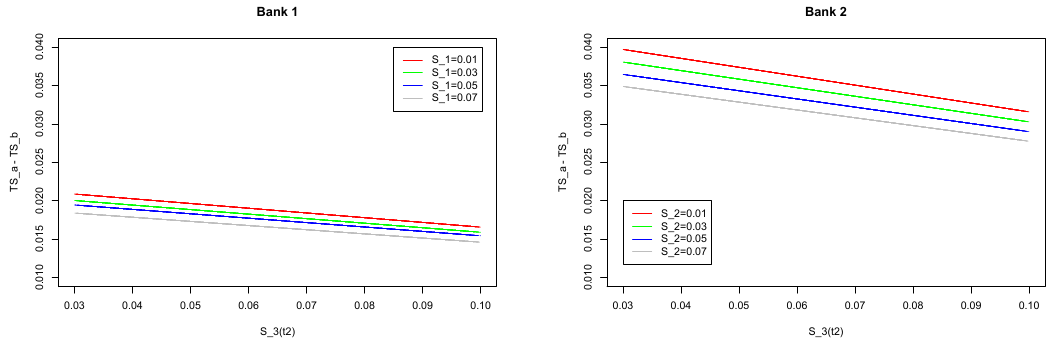
Figure 2. Changes in TS ’s as functions of S 3, t , stylized banking system. Notes: Monte Carlo simulated 2 differences between the total spreads in case of liquidation (Scenario (a)) and private intervention (Scenario (b)) for Bank 1 ( left ) and Bank 2 ( right ), plotted as functions of µ S . The safer and the smaller 3, t 2 the bank, the safer the banks in case of a private intervention; this effect, however, becomes weaker as the spread S 3, t increases in case of private 2